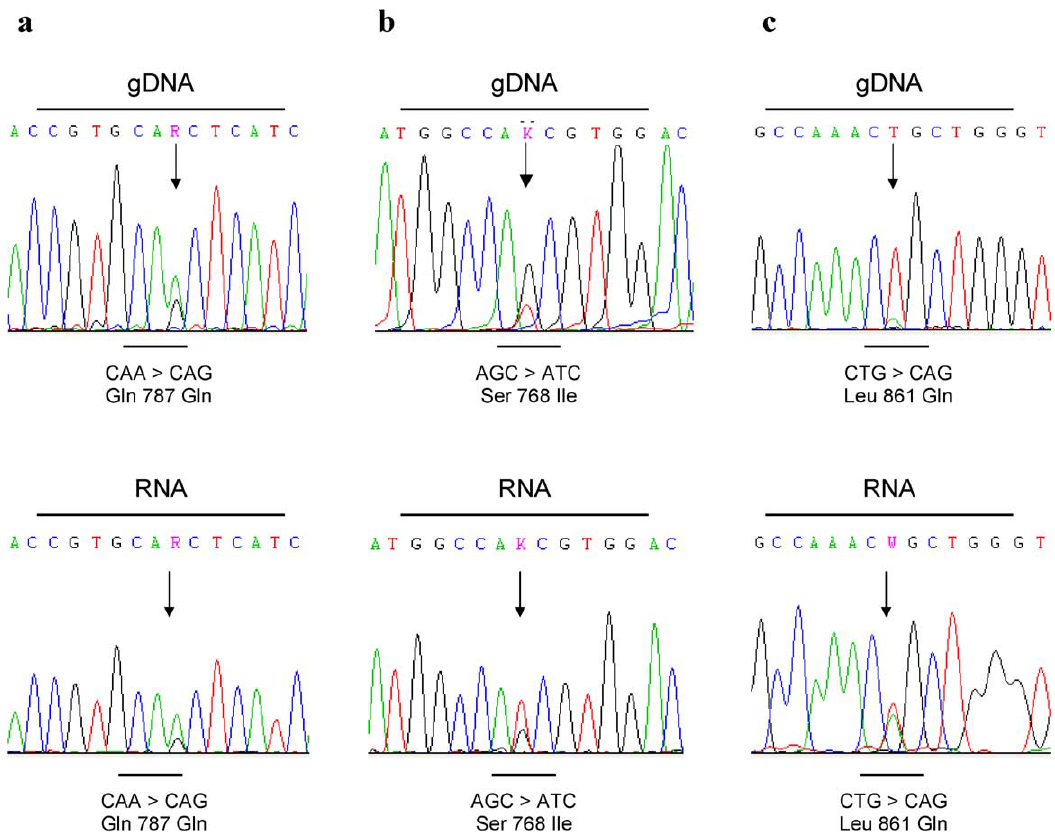
Fig. 2. Sequencing EGFR from gDNA and RNA in sample #8446712 showing the single nucleotide polymorphim Gln787Gln (a) and the EGFR point mutations Ser768Ile and Leu861Gln (b and c). Whereas the wildtype to mutant allele ratio in the polymorphism is comparable in the chromatograms form gDNA versus RNA (a – arrows), both EGFR point mutation peaks are elevated in the chromatograms from RNA compared to the chromatograms from gDNA (b and c –